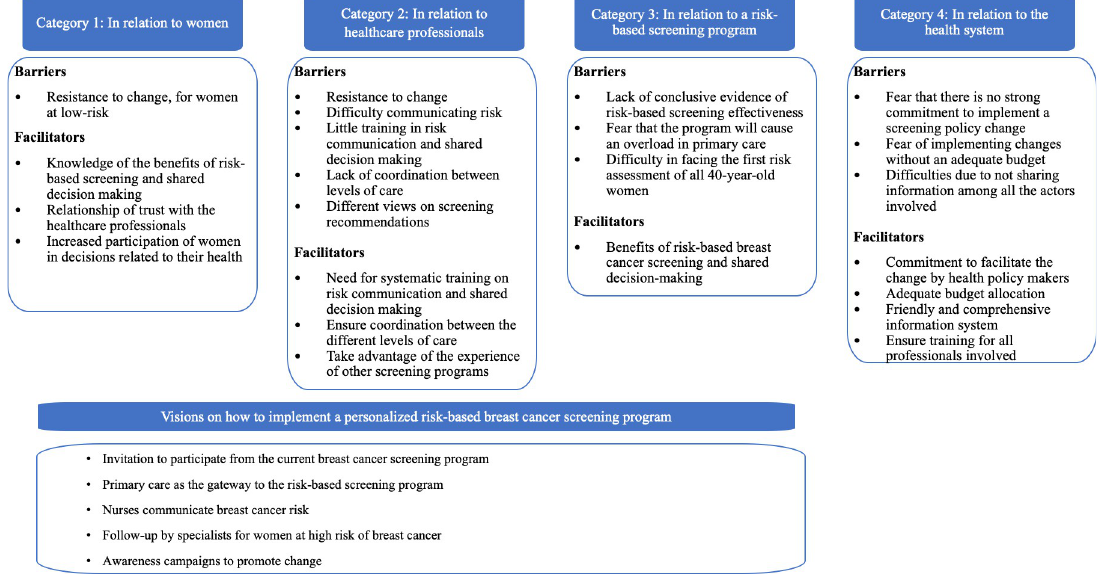
Fig 1. Visions of healthcare professionals on the implementation of risk-based screening for breast cancer.